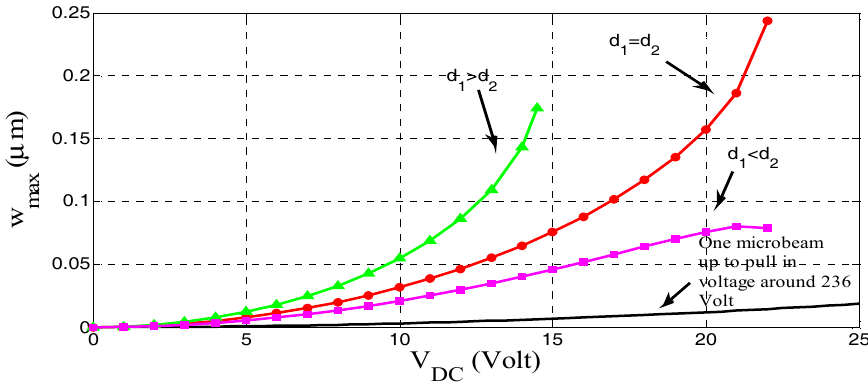
Figure 6 and Figure 7. Therefore, in all of the three investigated cases more deflection will be provided